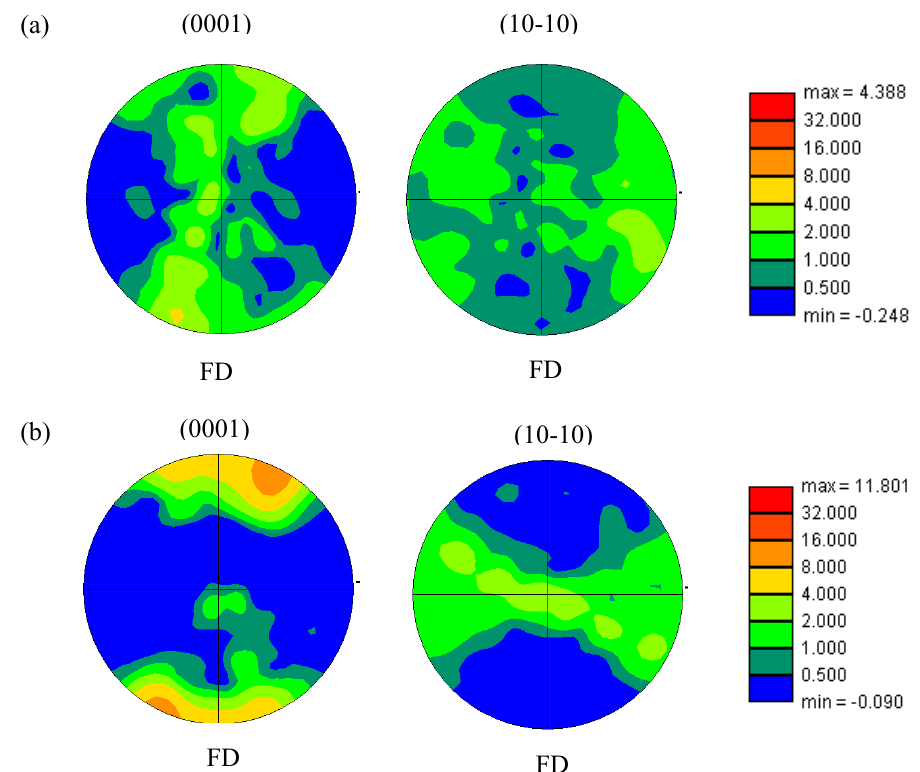
Figure 7. Pole figures of nano-SiCp/AZ91 composite after multi-pass forging: ( a ) for six passes (400-6P), ( b ) for 12 passes (400-6P + 350-3P).